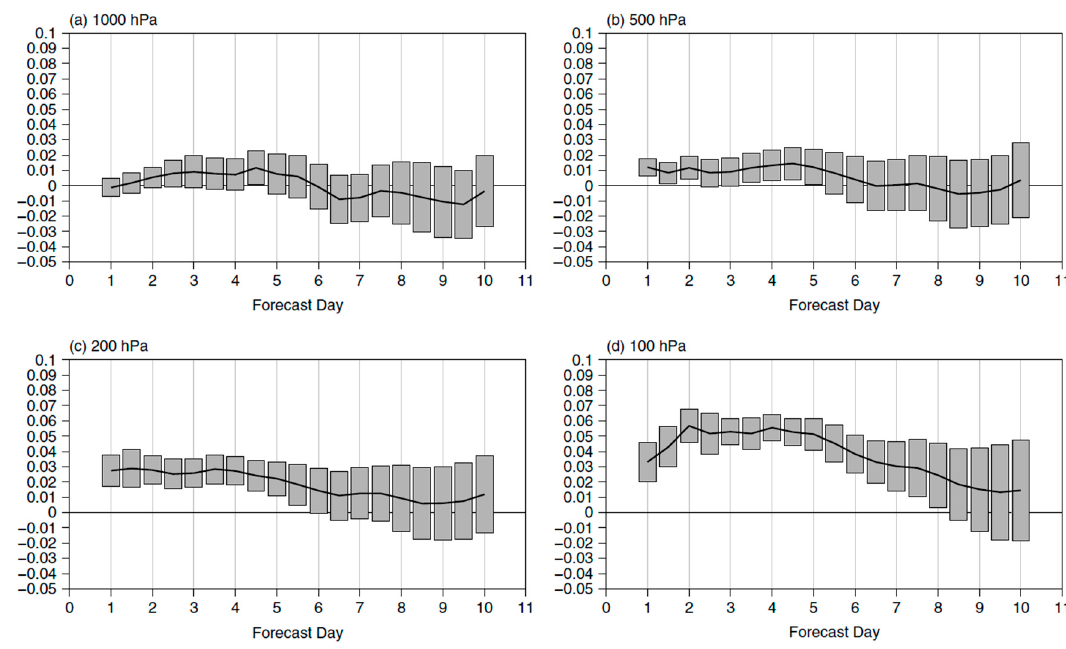
Figure 3. Impact of RO data for heights of 100, 200, 500, and 1000 hPa on the ECMWF operational forecast in the northern hemisphere, where the positive values indicate improved NWP. The y-axis represents the fractional improvement in the root mean square (RMS) geopotential height errors as a function of the forecast range, which is plotted along the x-axis, in the northern hemisphere (latitude > 20°) [40]. The error bars represent the 95% confidence interval.